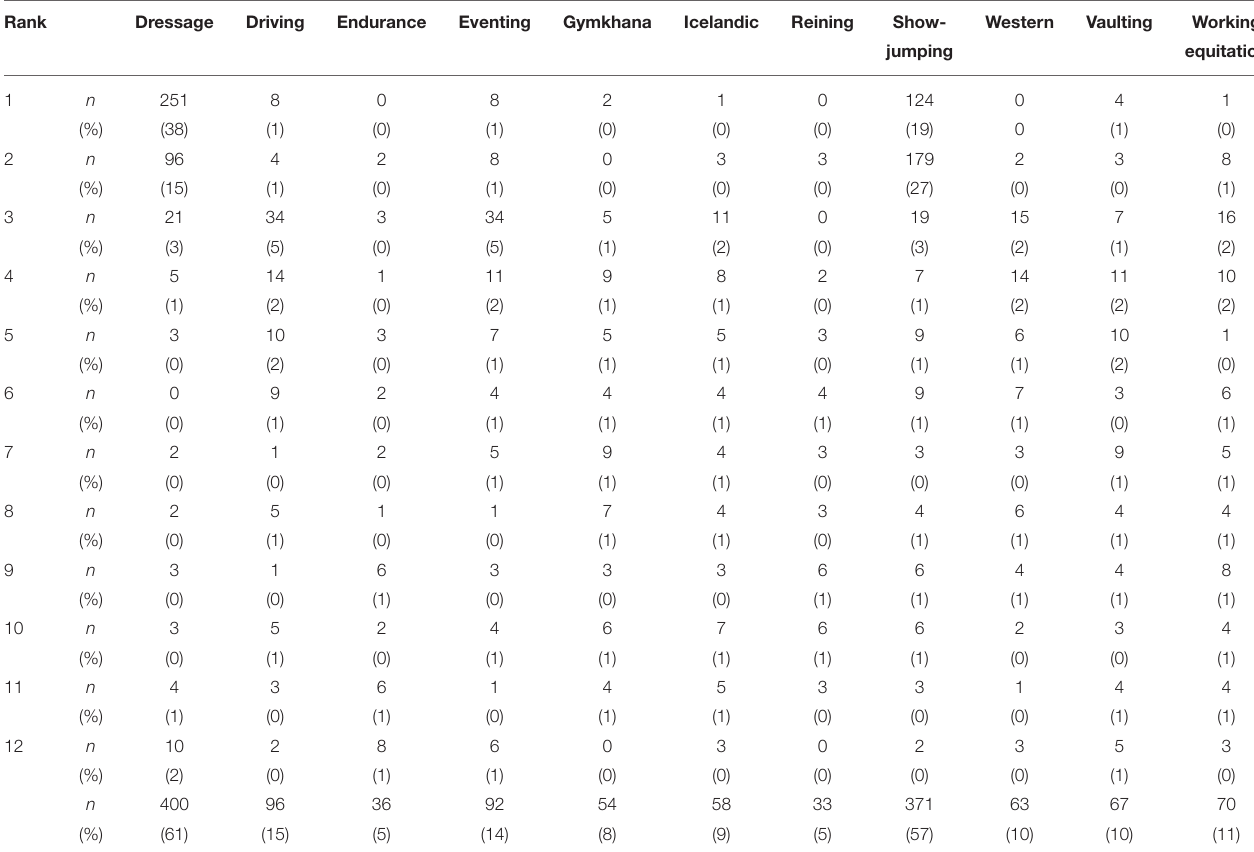
TABLE 8 | The disciplines performed on the arenas. Rank Dressage Driving Endurance Eventing Reining Show- Western Vaulting Working